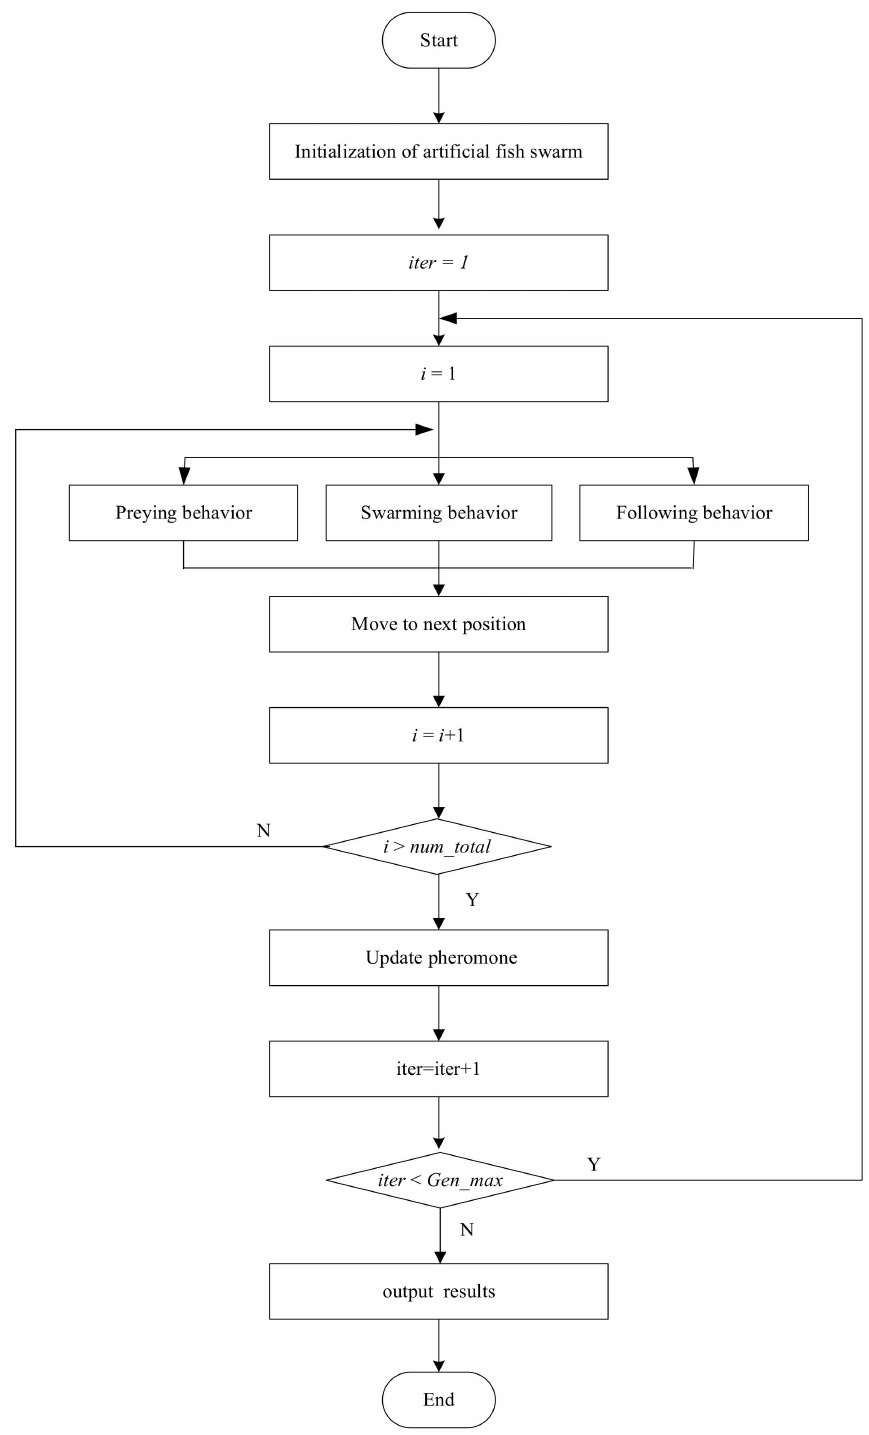
Figure 4. Flowchart of AFSAP